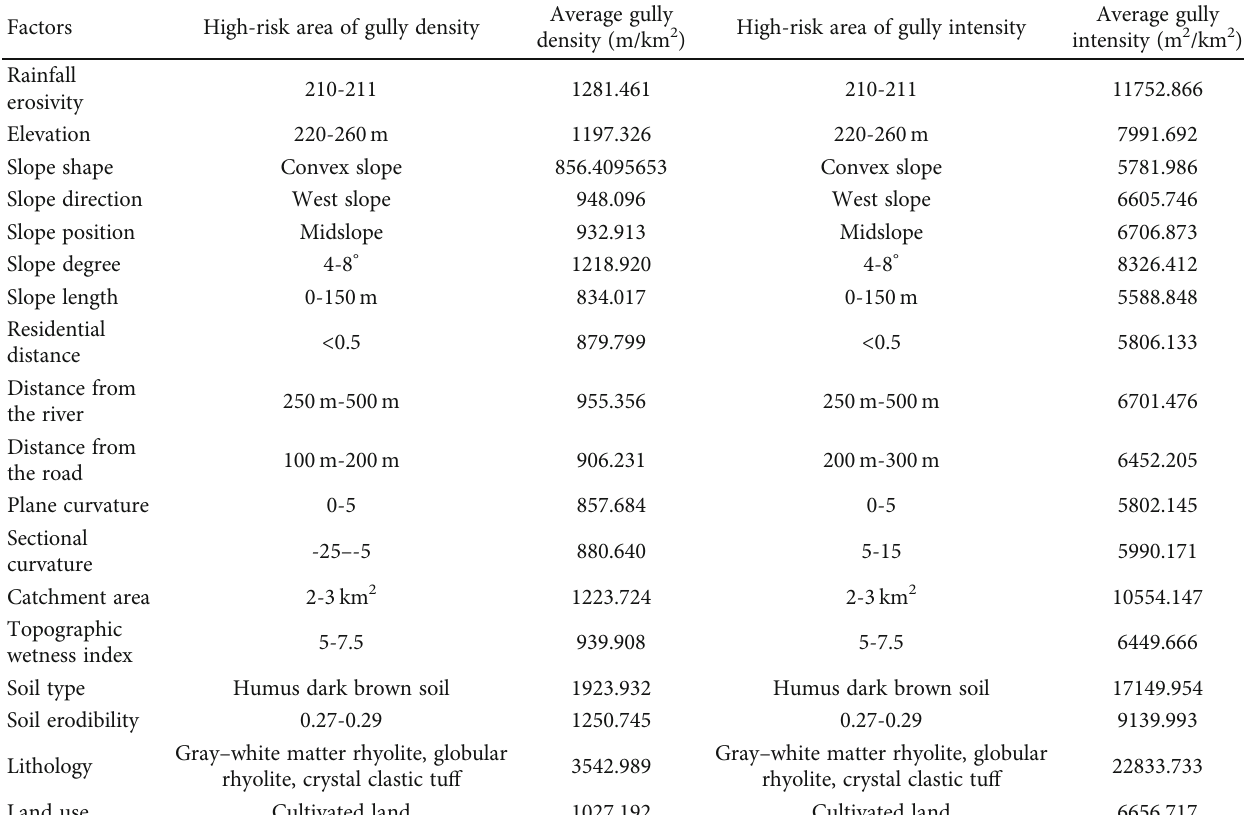
Table 8: High-risk areas of gully erosion and its mean